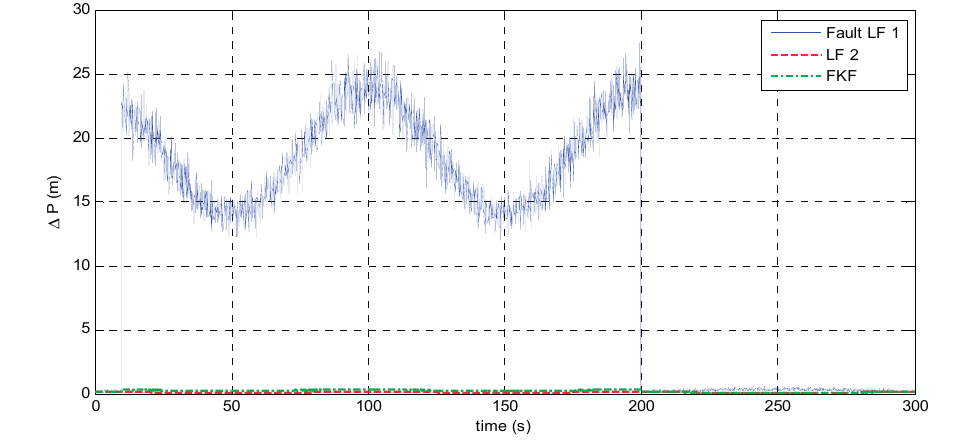
Figure 11. Attitude estimates when LF 1 fails.